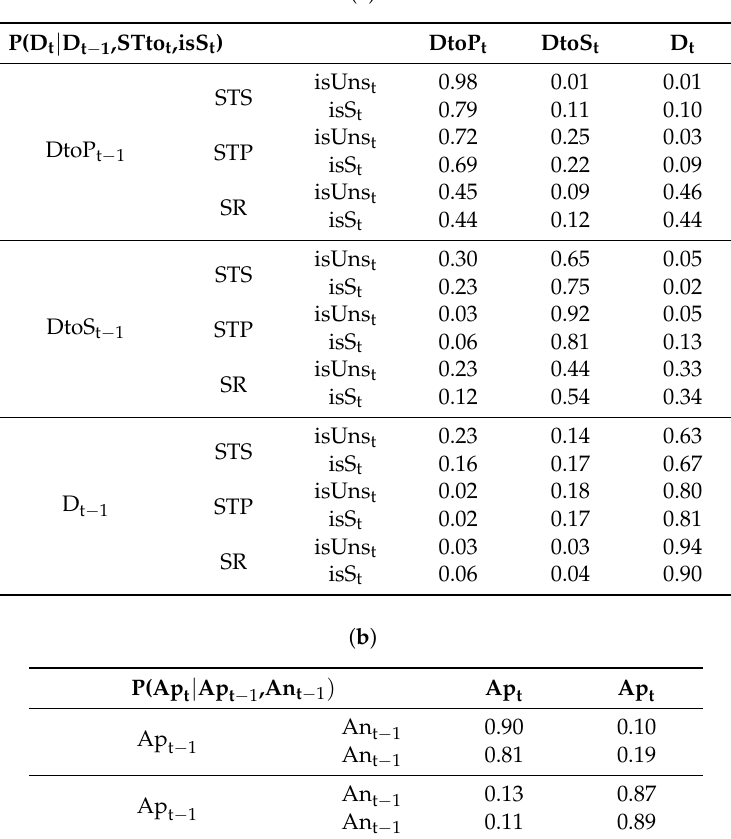
Table 4. Transfer matrix between time slices of DBN.